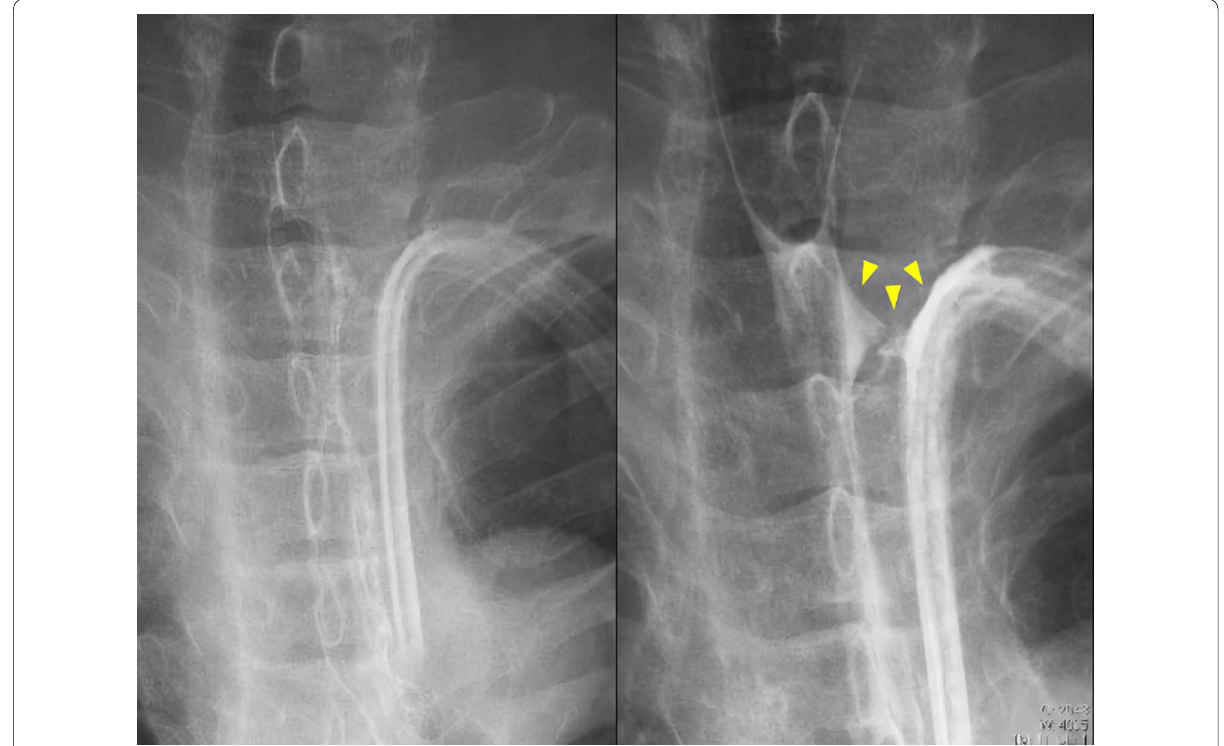
Fig. 4 Esophagogram on the ninth postoperative day. Contrast leakage (yellow arrowheads)